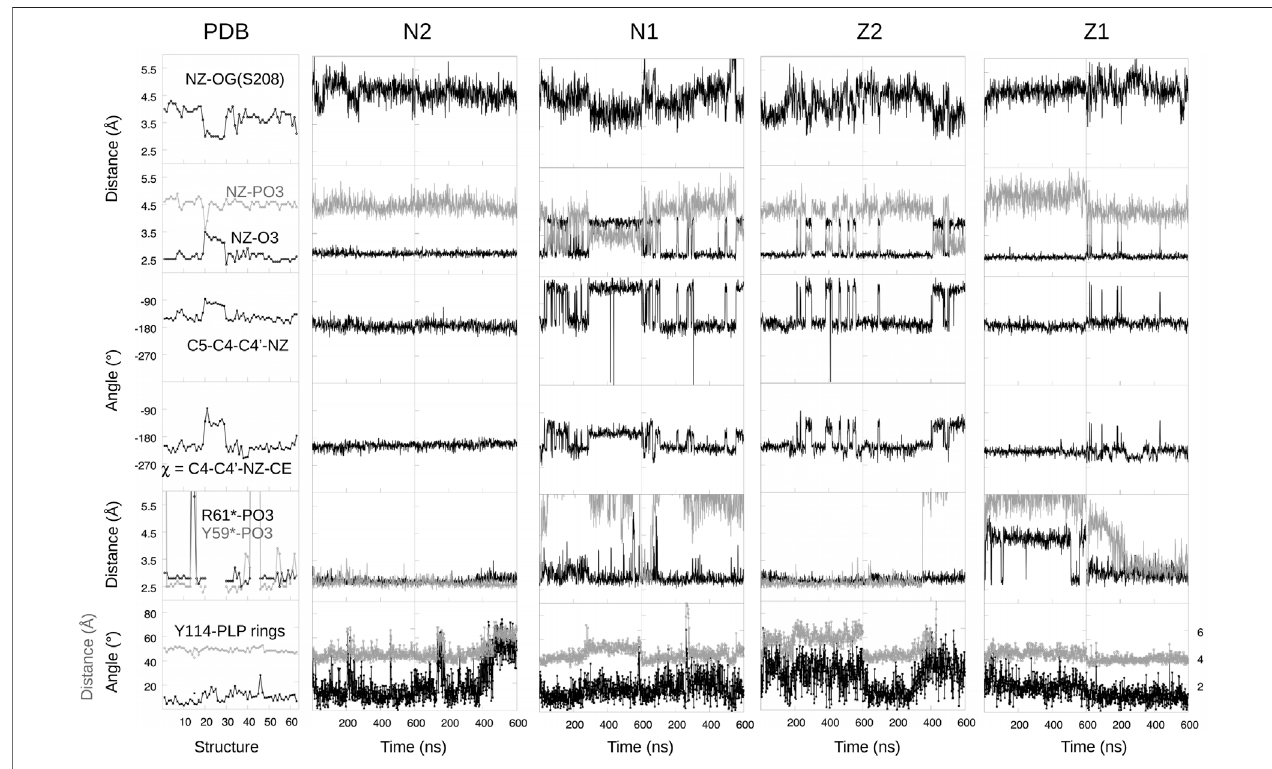
FIGURE 5 | Selected structural variables seen during